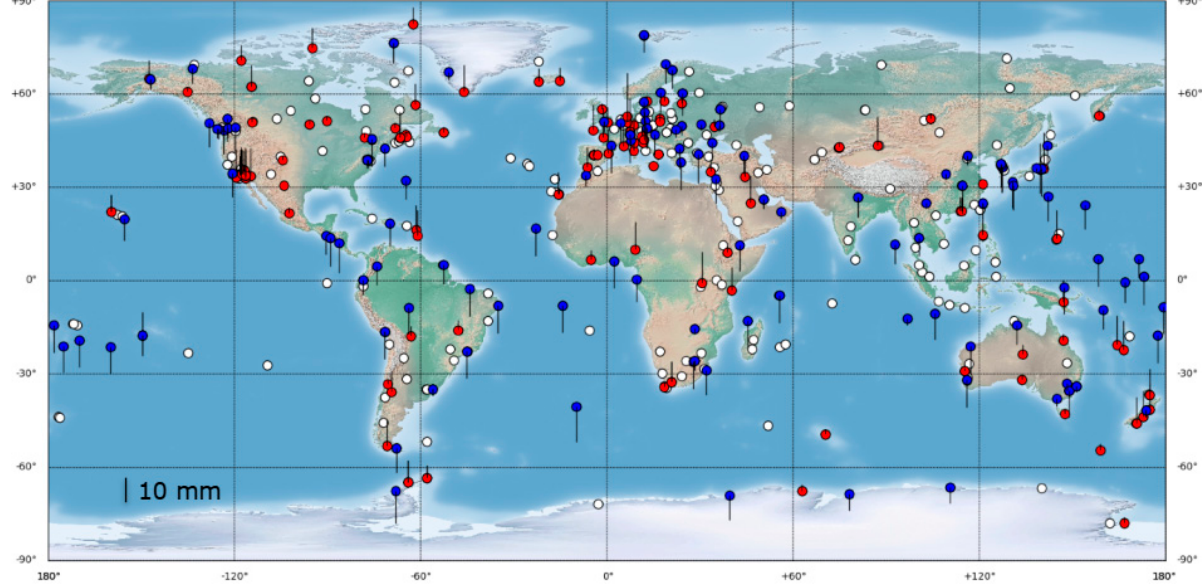
Figure 2. Height offset due to antenna model changes; red marks indicate positive height changes, blue marks indicate negative changes, and white indicates that no changes occurred. The ‘whiskers’ show the amount of height offset.